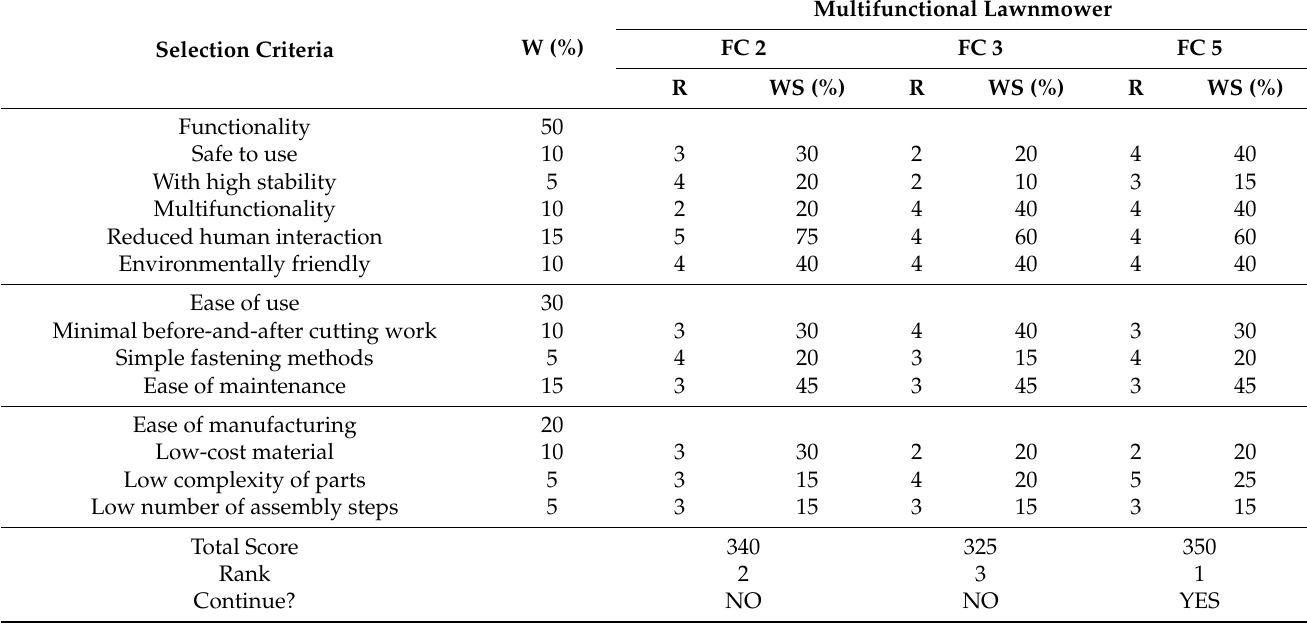
Table 14. Scoring of final